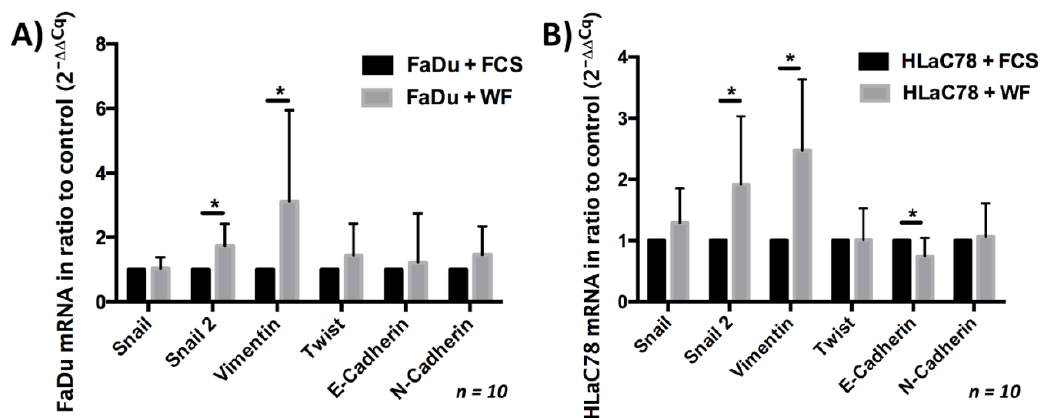
Figure 6. Expression of epithelial and mesenchymal markers after ( A ) FaDu and ( B ) HLaC78 incubation with WF. The expression of the mesenchymal markers Snail 2 and vimentin is significantly enlarged after incubation with WF in ( A ) FaDu and ( B ) HLaC78. Significant lower levels of the epithelial marker E-cadherin were detected in HLaC78 after incubation with WF (* p < 0.05).